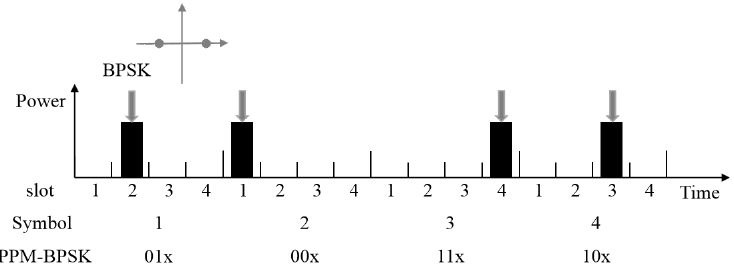
Figure 3. 4-PPM-BPSK modulation schematic